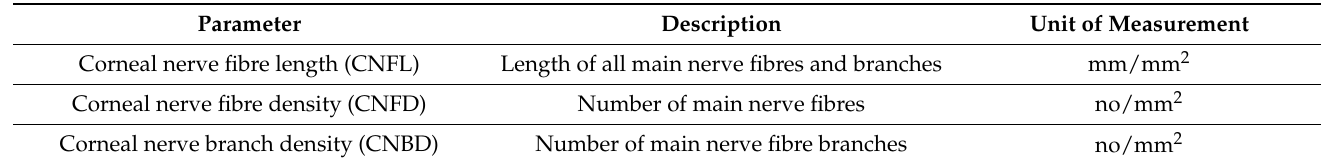
Table 2. Corneal confocal microscopy (CCM) biomarkers.